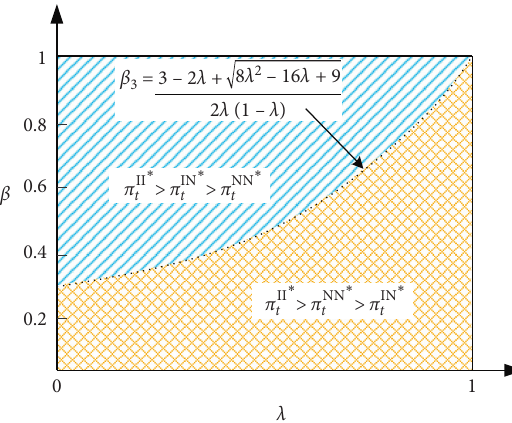
Figure 8: The whole supply chain’s profits comparison among three